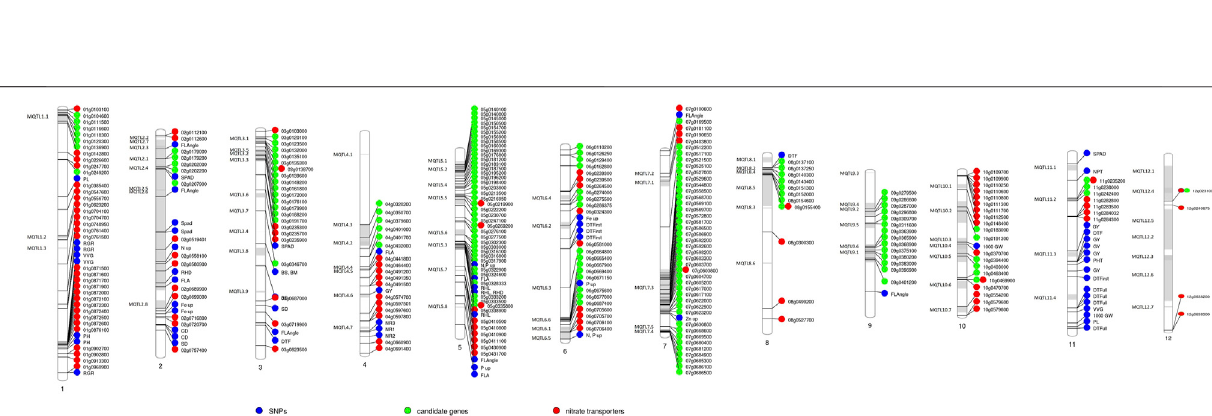
FIGURE 4 | Syntenic relationship of rice candidate genes present in the MQTL region with the (A) wheat, (B) maize, and (C) barley genome.